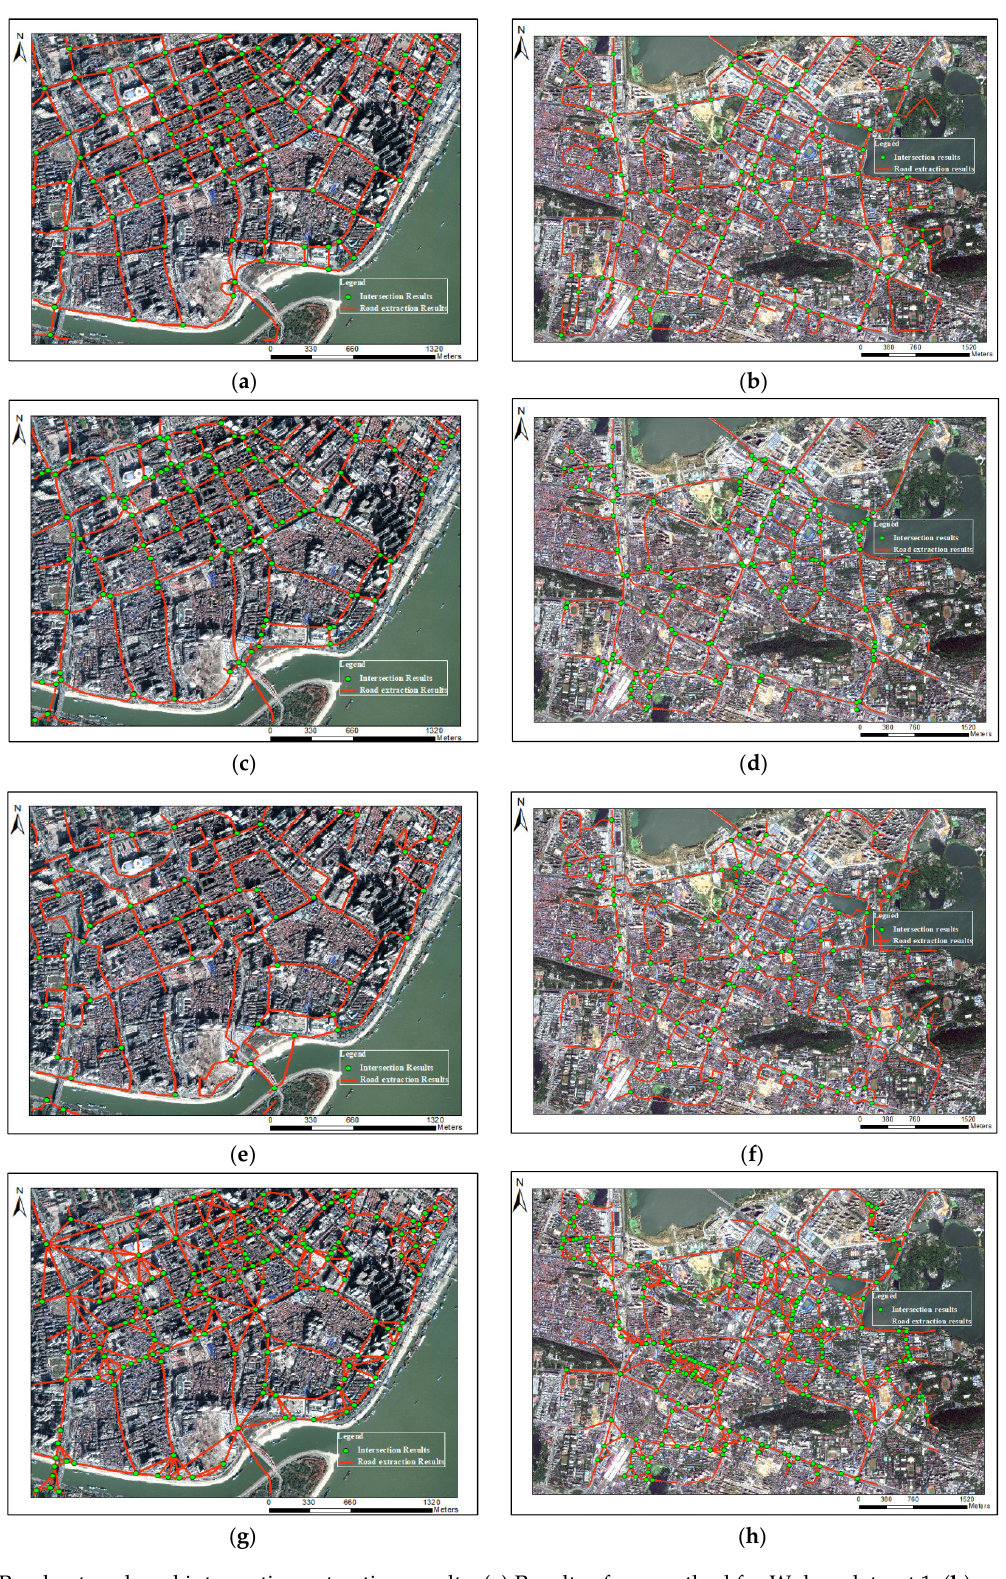
Figure 9. Road network and intersection extraction results. ( a ) Results of our method for Wuhan dataset 1; ( b ) results of our method for Wuhan dataset 2; ( c ) results of Davies’ method for Wuhan dataset 1; ( d ) results of Davies’ method for Wuhan dataset 2; ( e ) results of Ahmed’s method for Wuhan dataset 1; ( f ) results of Ahmed’s method for Wuhan dataset 2; ( g ) results of Karagiorgou’s method for Wuhan dataset1; ( h ) results of Karagiorgou’s method for Wuhan dataset 1.